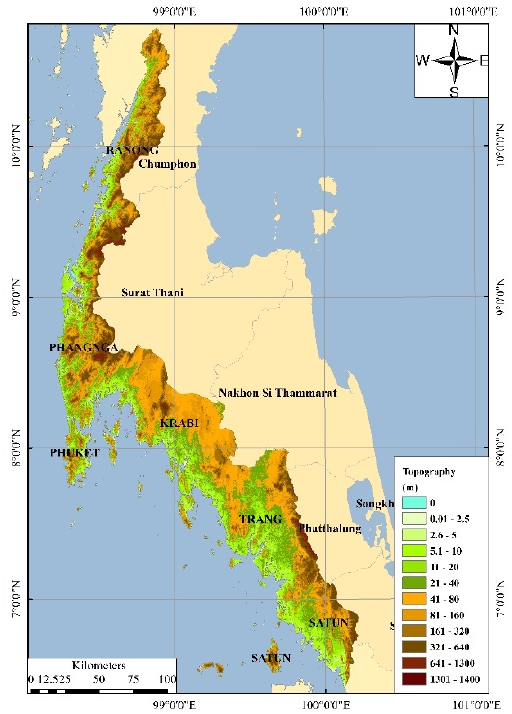
Figure 2. Topography map of the study area along the coast of the Andaman Sea.